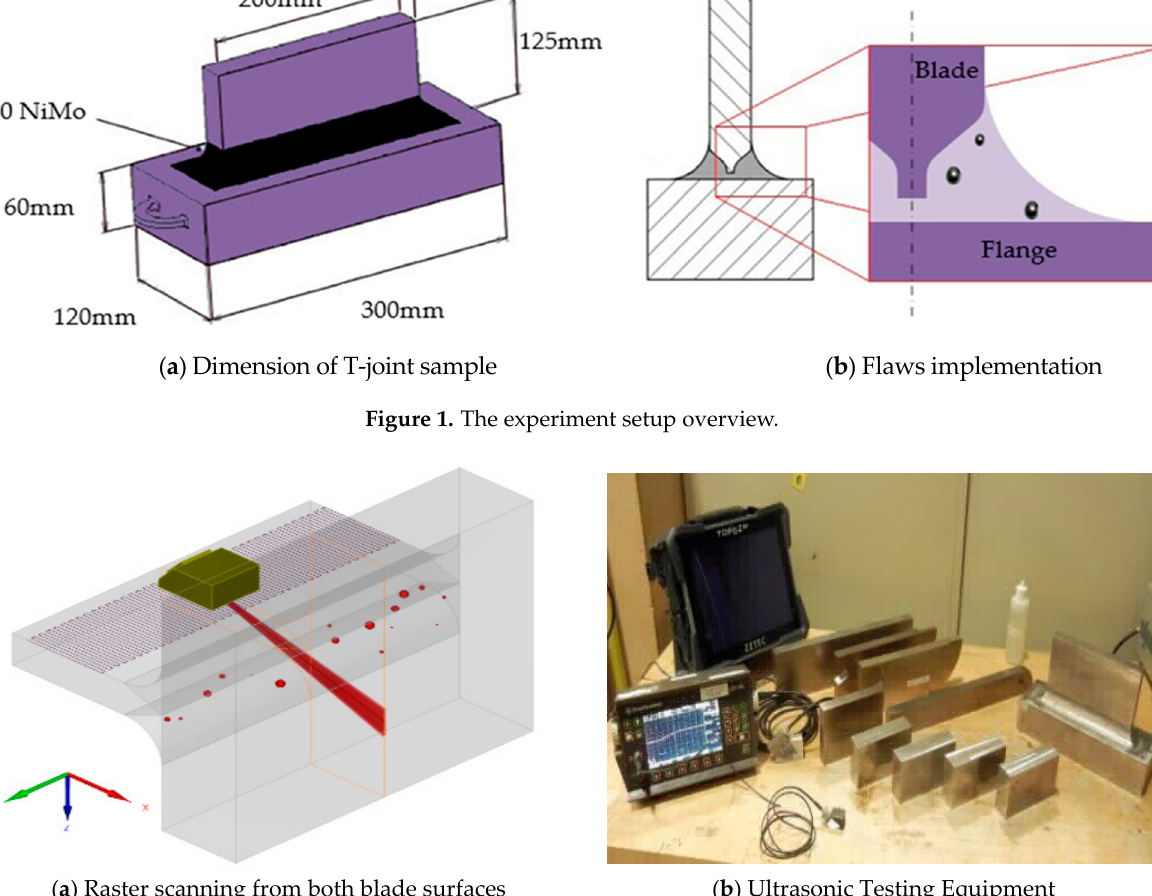
Figure 1. The experiment setup overview.